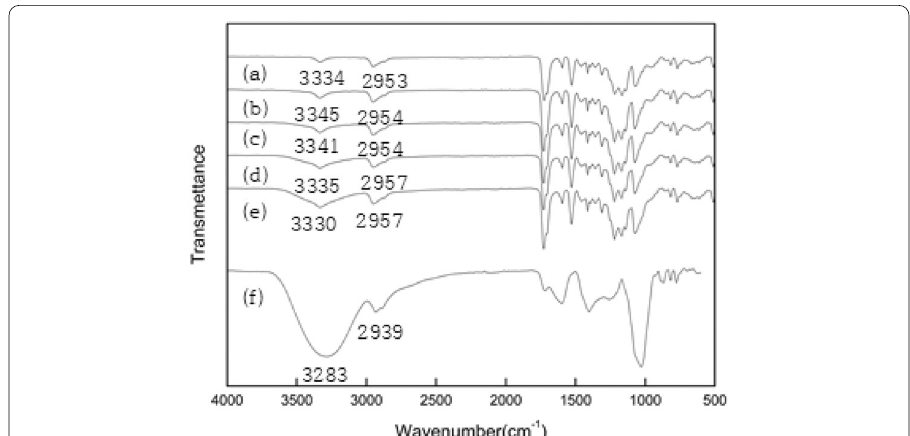
Fig. 4 FT-IR spectra of the PU/AE nanofibers for different AE concentrations: a 0 wt%, b 0.5 wt%, c 1 wt%, d 2 wt%, e 3 wt%, and f AE distilled water extracts (PU solution concentration: 12%, Voltage: 20 kV and TCD:15